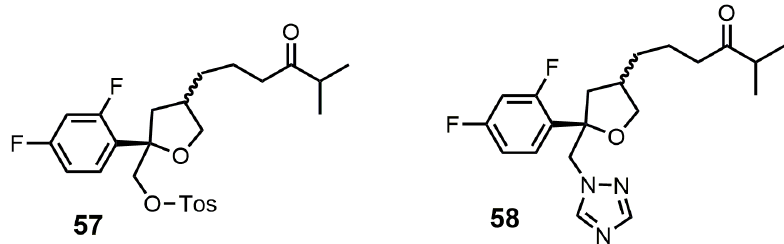
Figure 29. Structures of compounds designed to be bifunctional SDM and sterol C24-methyltransferase (24-SMT) inhibitors.